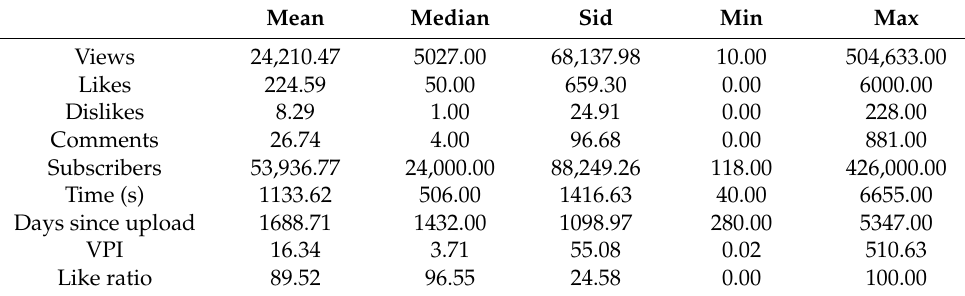
Table 1. Video descriptive statistics.